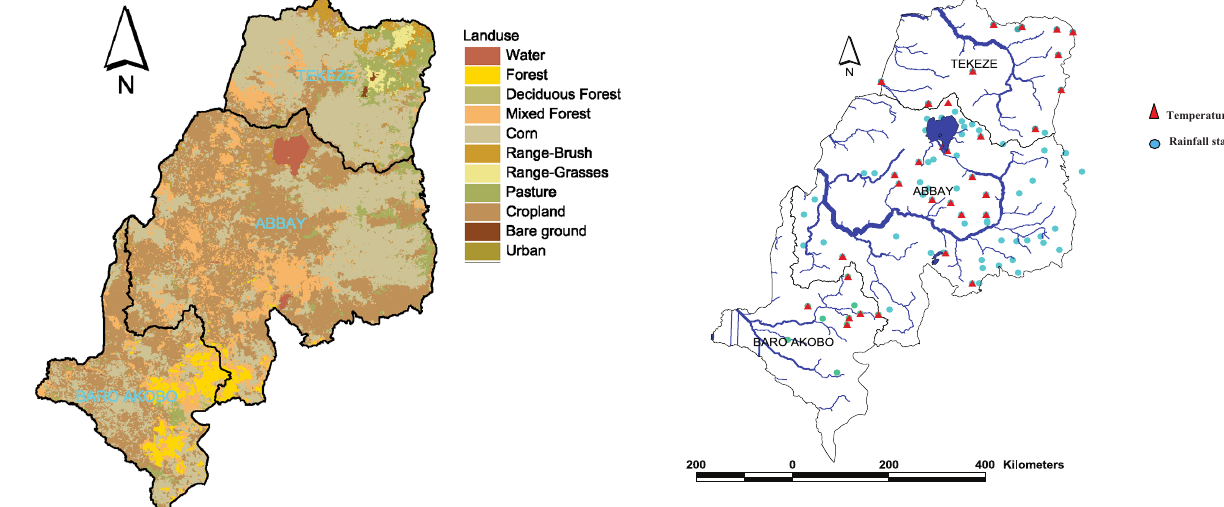
Figure 5: Main rivers and meteorological stations in the eastern Nile basin. Fig. 5. Main rivers and meteorological stations in the eastern Nile